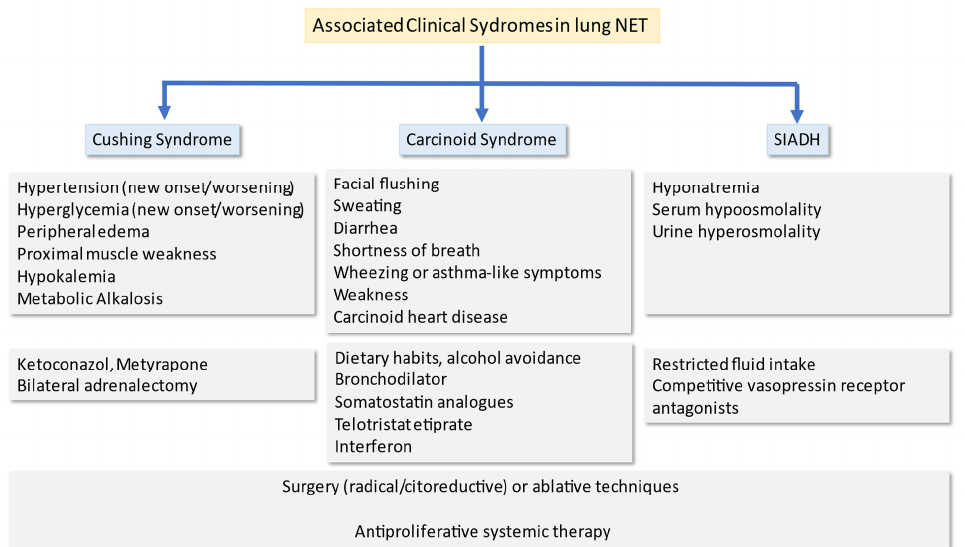
Figure 3. Associated clinical syndromes in bronchial carcinoids: clinical manifestation and treat- ment